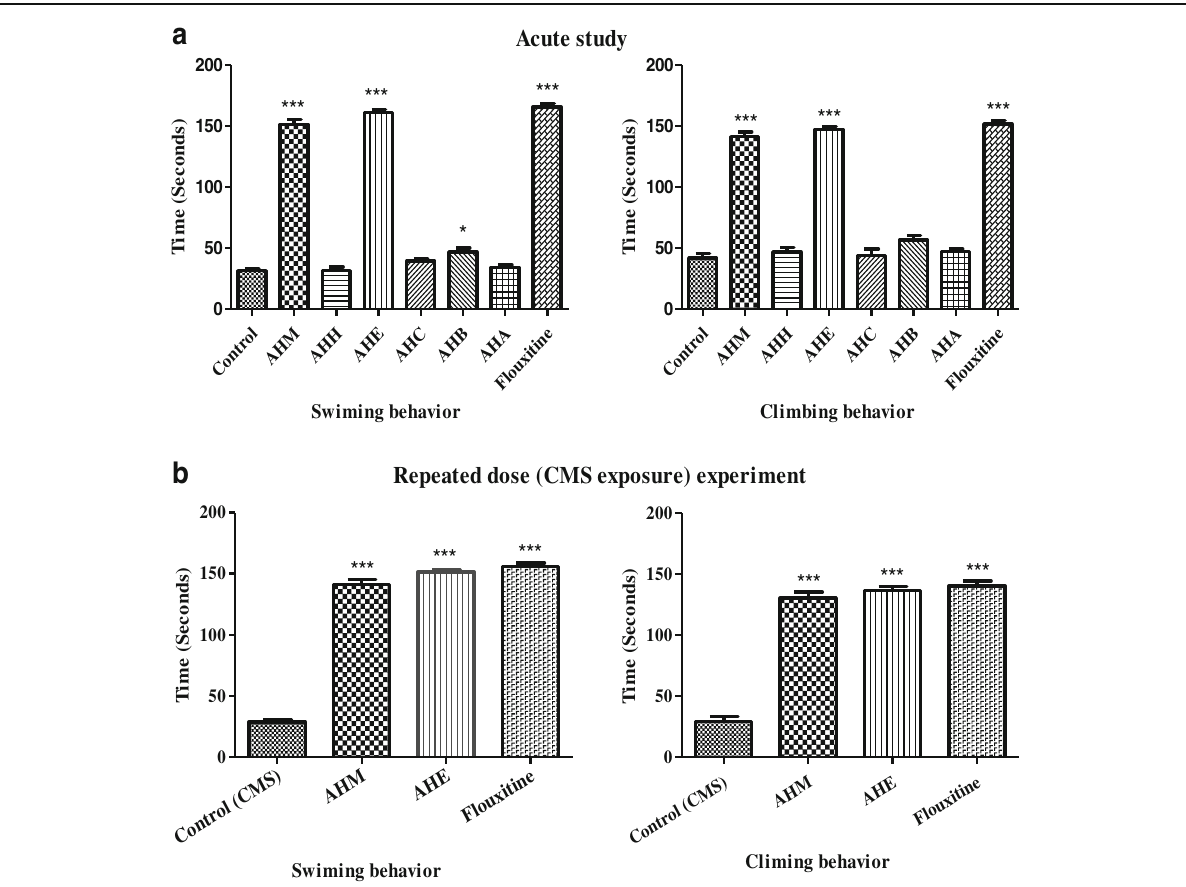
Fig. 3 Effect of acute and repeated dose of A. hydaspica extract/fraction (200 mg/kg b.w, p.o ) and fluoxetine (10 mg/kg b.w, i.p .) on behavioral pattern in forced swing test in rats. a Effect acute dose on swimming and climbing behavior, b Effect repeated doses of AHM, AHE and fluoxetine on swimming and climbing behavior. Data presented as mean ± SEM ( n = 6). Asterisks ***, * indicate significant ( p < 0.001 and p < 0.05 respectively) difference from respective control. Data analyzed by one way ANOVA followed by Tukey ’ s multiple comparison